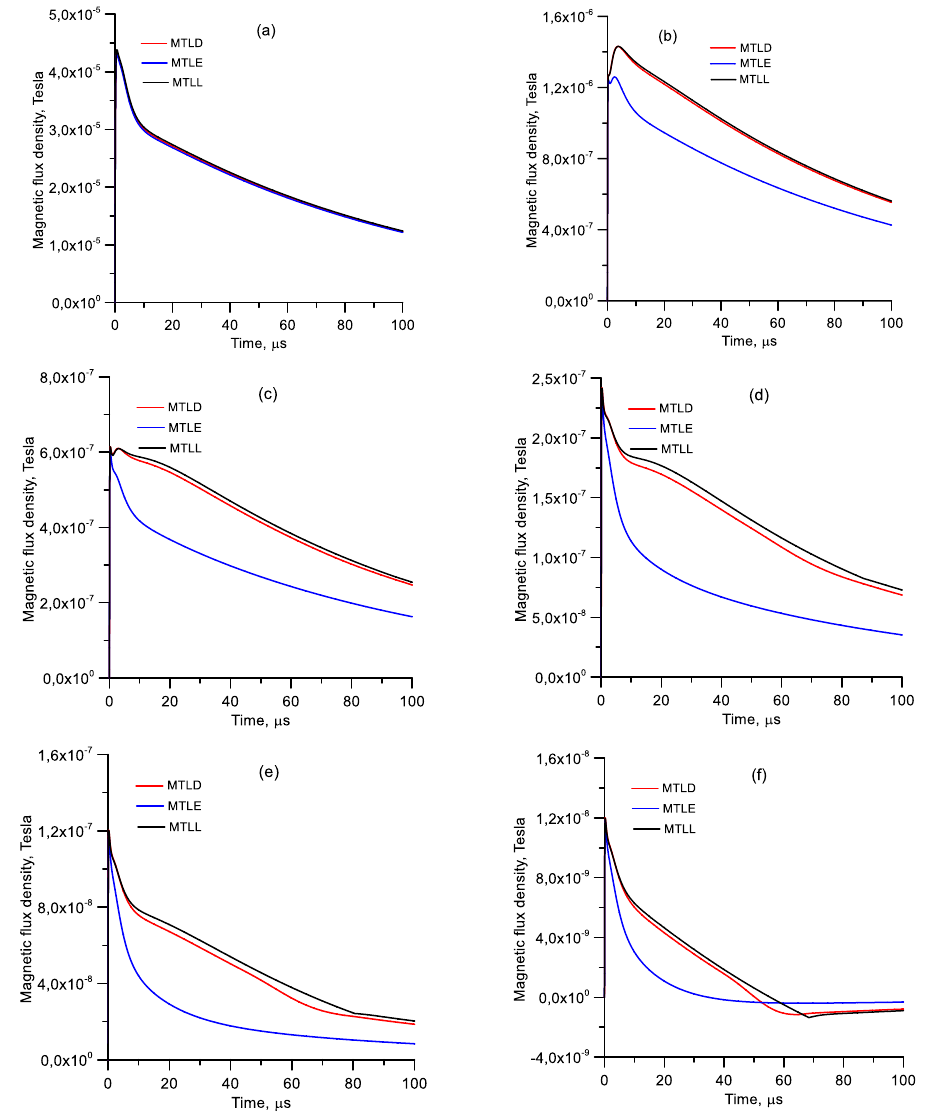
Figure 6. Magnetic fields of subsequent return strokes at different distances as predicted by the MTLD, MTLE and MTLL models. ( a ) 50 m, ( b ) 1 km, ( c ) 2 km, ( d ) 5 km, ( e ) 10 km and ( f ) 100 km. In the MTLE model, λ = 2.0 km and, in the MTLL model, H = 10 km are used as model parameters. The return stroke speed is assumed to be constant and equal to 1.5 × 10 8 m/s.